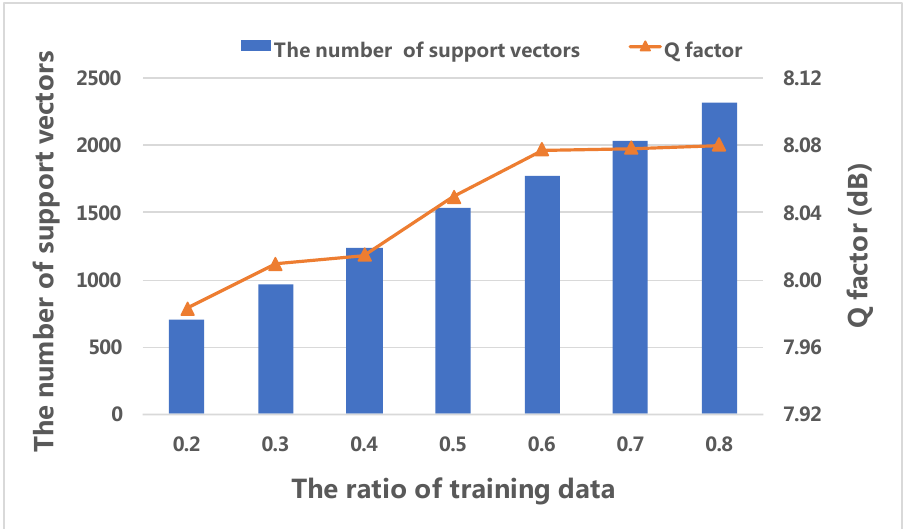
Figure 9. Q factor and the number of support vectors versus the ratio of training